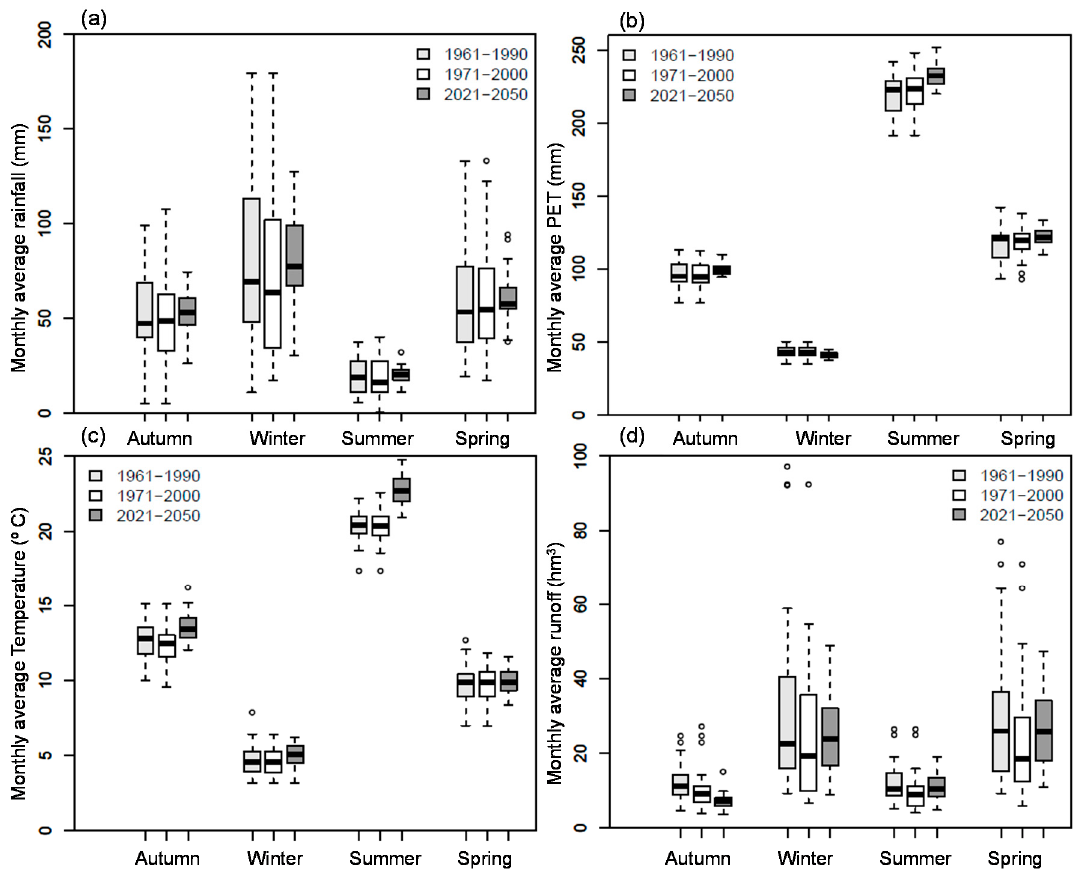
Figure 10. Boxplots of mean seasonal variation for the 1961–1990 and 1971–2000 historical periods, and the 2021–2050 projection for the Fuensanta Basin: ( a ) rainfall; ( b ) potential evapotranspiration; and ( c ) mean temperature; and ( d ) simulated runoff.